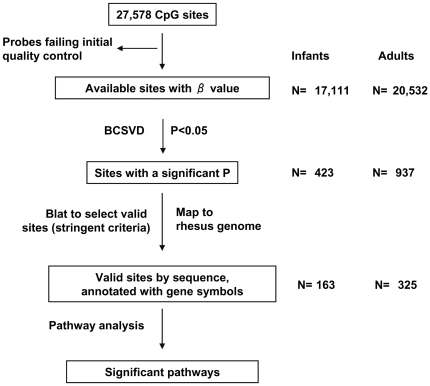
Flow chart of the experimental design and overview of the results.